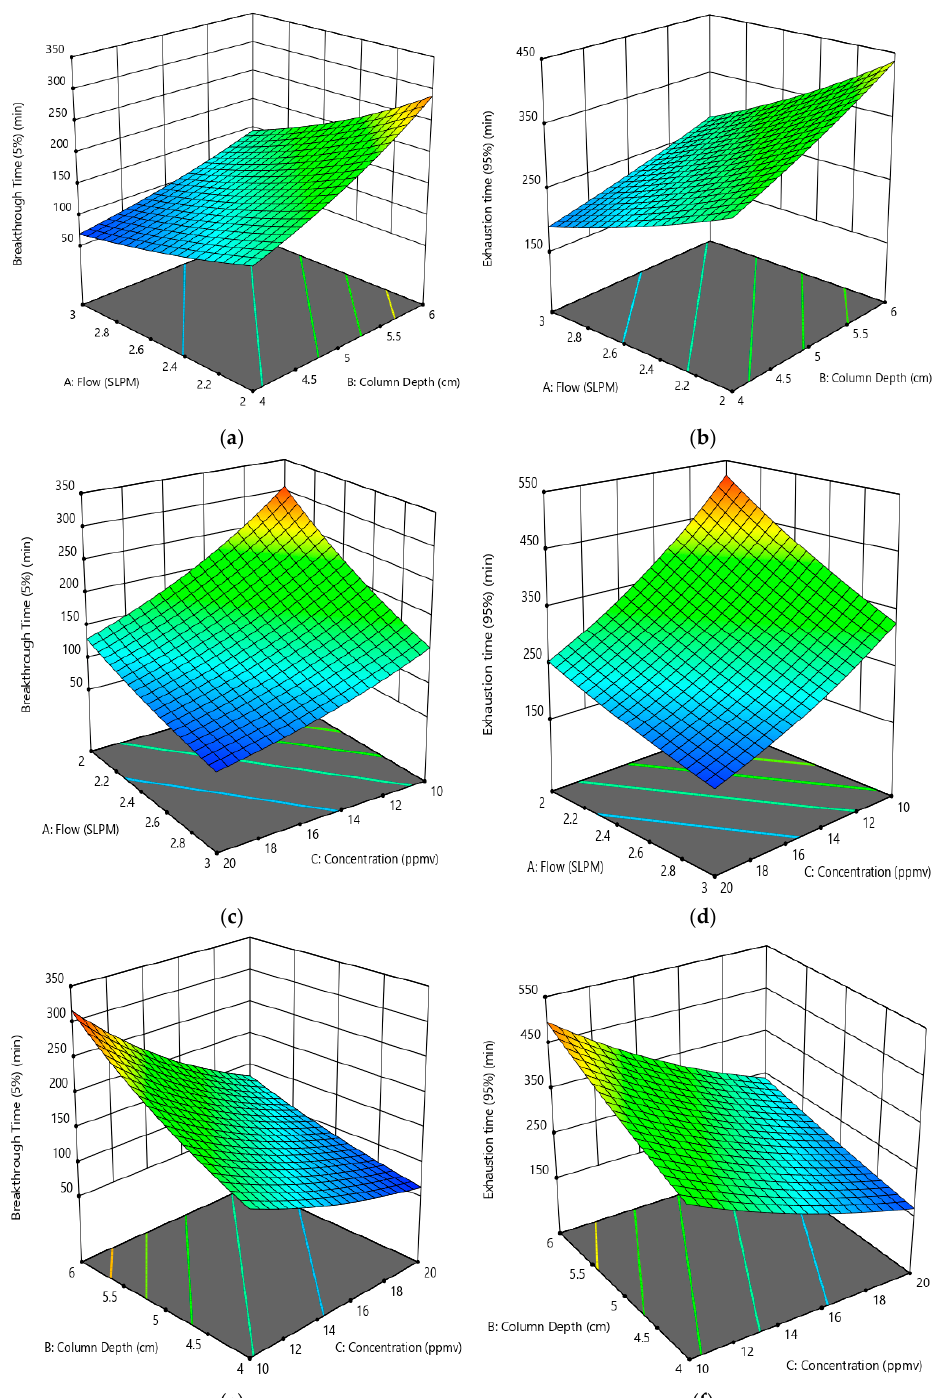
Figure 7. Response surface profiles showing the variation of ( a ) toluene breakthrough times (min) with toluene flow rate (slpm) and column depth (cm) (influent toluene concentration 15 ppmv). ( b ) Toluene exhaustion times (min) with toluene flow rate (slpm) and column depth (cm) (influent toluene concentration 15 ppmv). ( c ) Toluene breakthrough times (min) with toluene flow Rate (slpm) and influent toluene concentration (ppmv) (column depth 5 cm). ( d ) Toluene exhaustion times (min) with toluene flow rate (slpm) and influent toluene concentration (ppmv) (column depth 5 cm). ( e ) Toluene breakthrough times (min) with column depth and influent toluene concentration (ppmv) (toluene flow rate 2.5 slpm). ( f ) Toluene exhaustion times (min) with column depth and influent toluene concentration (ppmv) (toluene flow rate 2.5